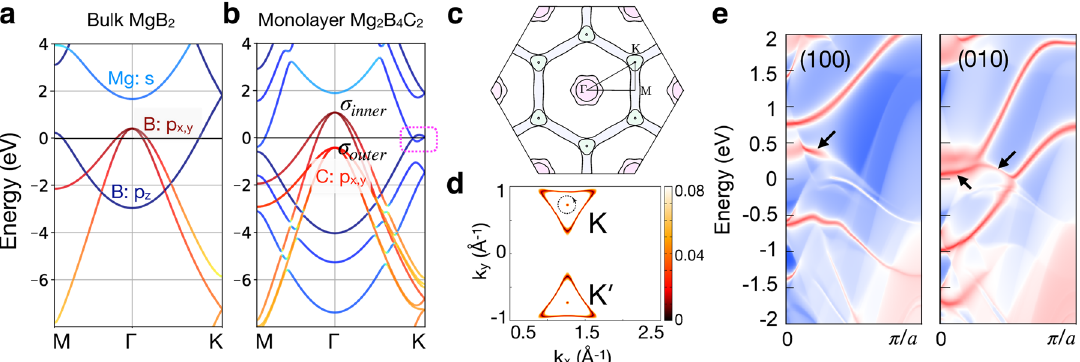
Fig. 2 Electronic structure. Atomic orbitals projected electronic band structure of ( a ) bulk MgB 2 , and ( b ) monolayer Mg 2 B 4 C 2 calculated without spin-orbit coupling (SOC) along the high symmetry direction of BZ. Cyan, red, and blue colors represent the contribution from the s, p x , y , and p z orbitals, respectively. See Supplementary Fig. 4 for more details. c Calculated Fermi surface of monolayer Mg 2 B 4 C 2 . Light pink/ green, and grey colors depict hole/electron, and intertwined electron-hole pockets, respectively. d Energy bandgap ( E gap ) plotted in color scale (eV units) in the vicinity of a K high-symmetry point. The dashed circle marks the k -loop along which Berry phase was computed. e The local electronic density of states of the (100) and (010) edge states spectrum. Red/White color denotes the states near the edge/interior of the 2D system. Topological nontrivial edge states are marked using arrows.